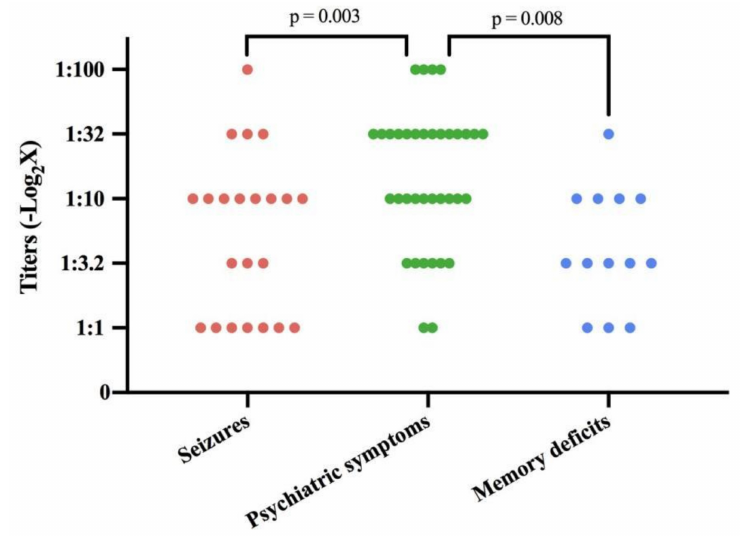
Figure 2. Cerebrospinal fluid antibody titers in patients with different onset symptoms.